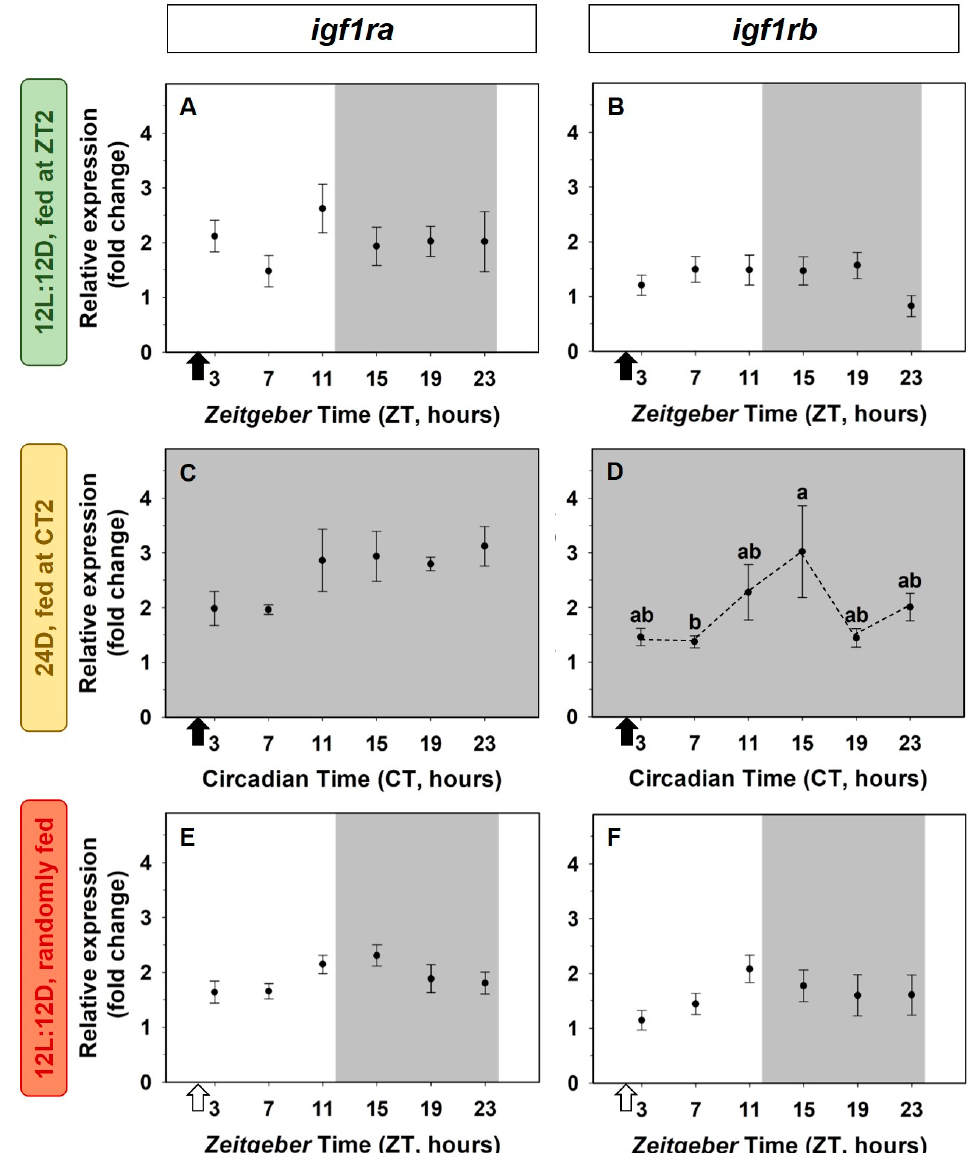
Figure 4. Daily variations of igf1ra ( A , C , E ) and igf1rb ( B , D , F ) expression in the liver of goldfish. ( A , B ) Standard conditions group (12L:12D photoperiod, feeding time at ZT2); ( C , D ) 24D group (24 h darkness, feeding time at CT2); ( E , F ) random feeding group (12L:12D photoperiod, randomly fed). Data are expressed as mean ± s.e.m. ( n = 7/sampling time). Different letters indicate statistical differences among sampling times (ANOVA). Dashed lines represent significant differences among sampling points by ANOVA. Black arrows indicate feeding time. White arrows indicate the time of the last feeding. The dark period is represented in